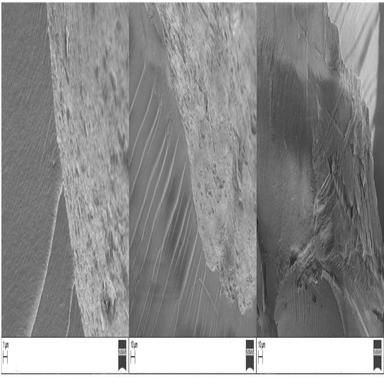
SEM images of the aged plastic constrictive element.